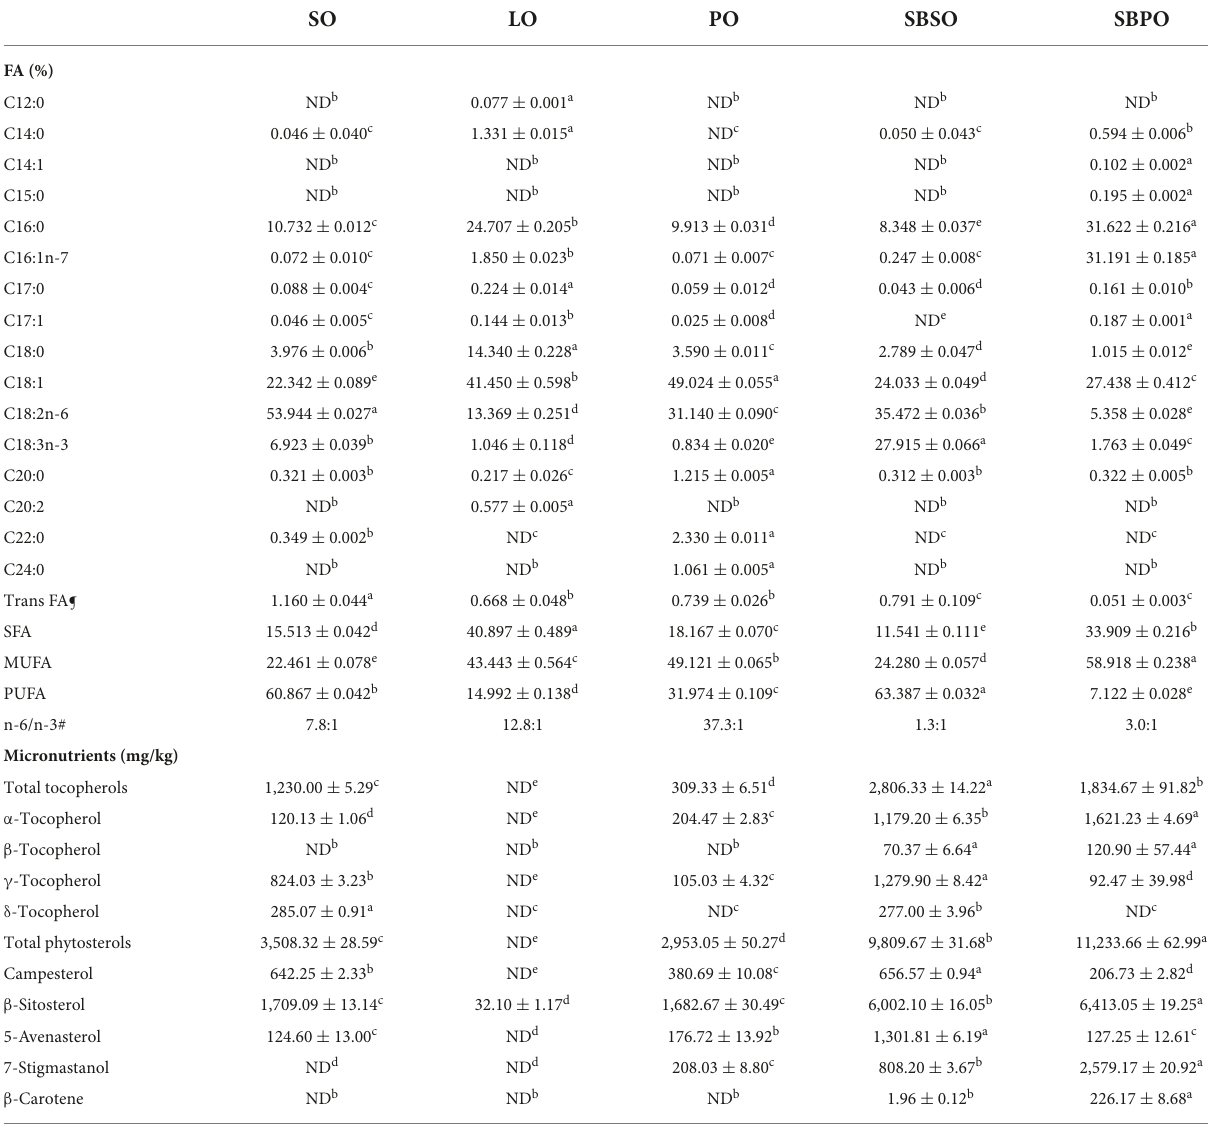
*Differentletters(a,b,c,d,ande)indicatesignificantdifferences( P < 0.05).ND,notdetected. ¶ TransFAincludestrans-18:1,trans-18:2,andtrans-18:3,whicharenotcountedinSFA,MUFA,orPUFA. # n-6/n-3isrepresentedbytheratioofC18:2n-6toC18:3n-3.